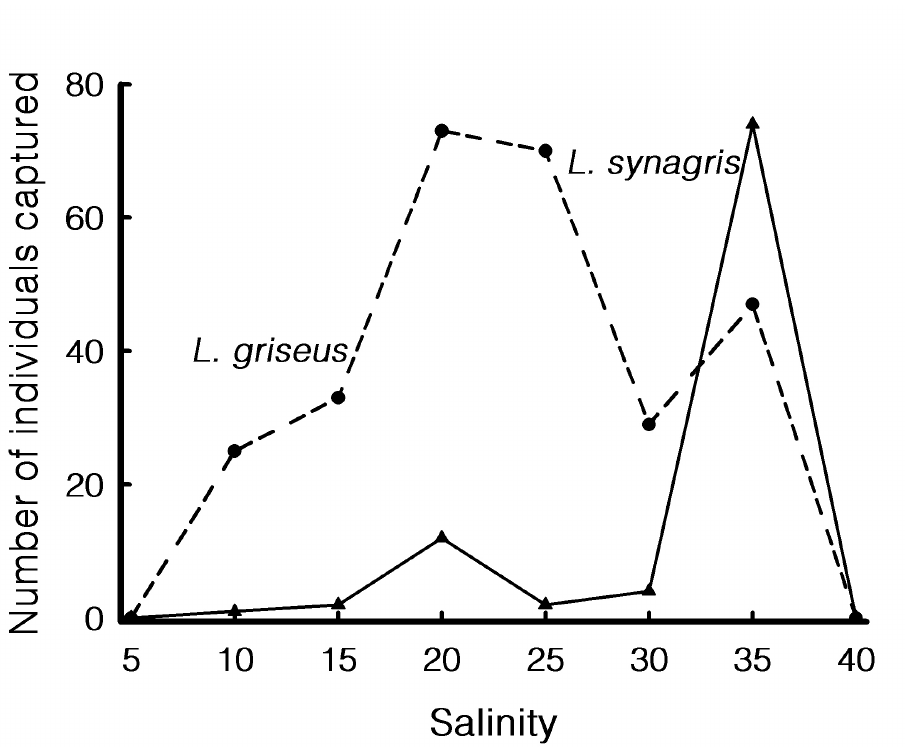
synagris , according to a salinity